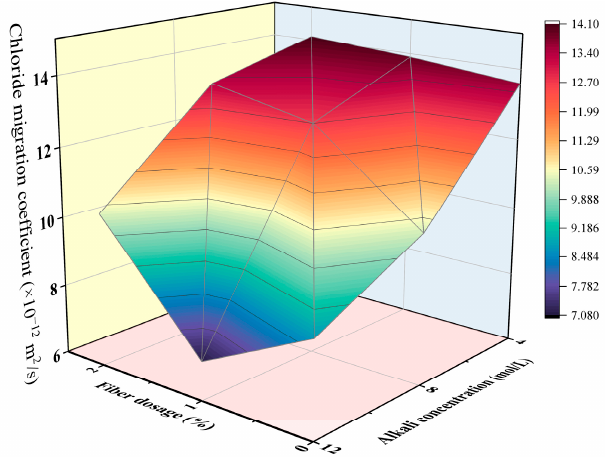
Figure 10. The combined influence of steel fiber dosage and NaOH solution concentration on the non-steady chloride diffusion coefficient.